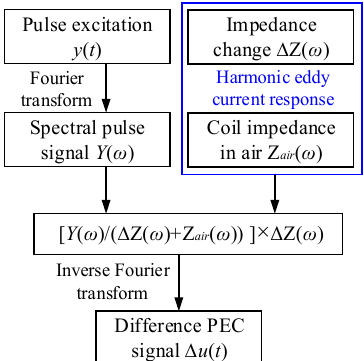
Figure 1. Flow chart of pulsed eddy current (PEC) model.